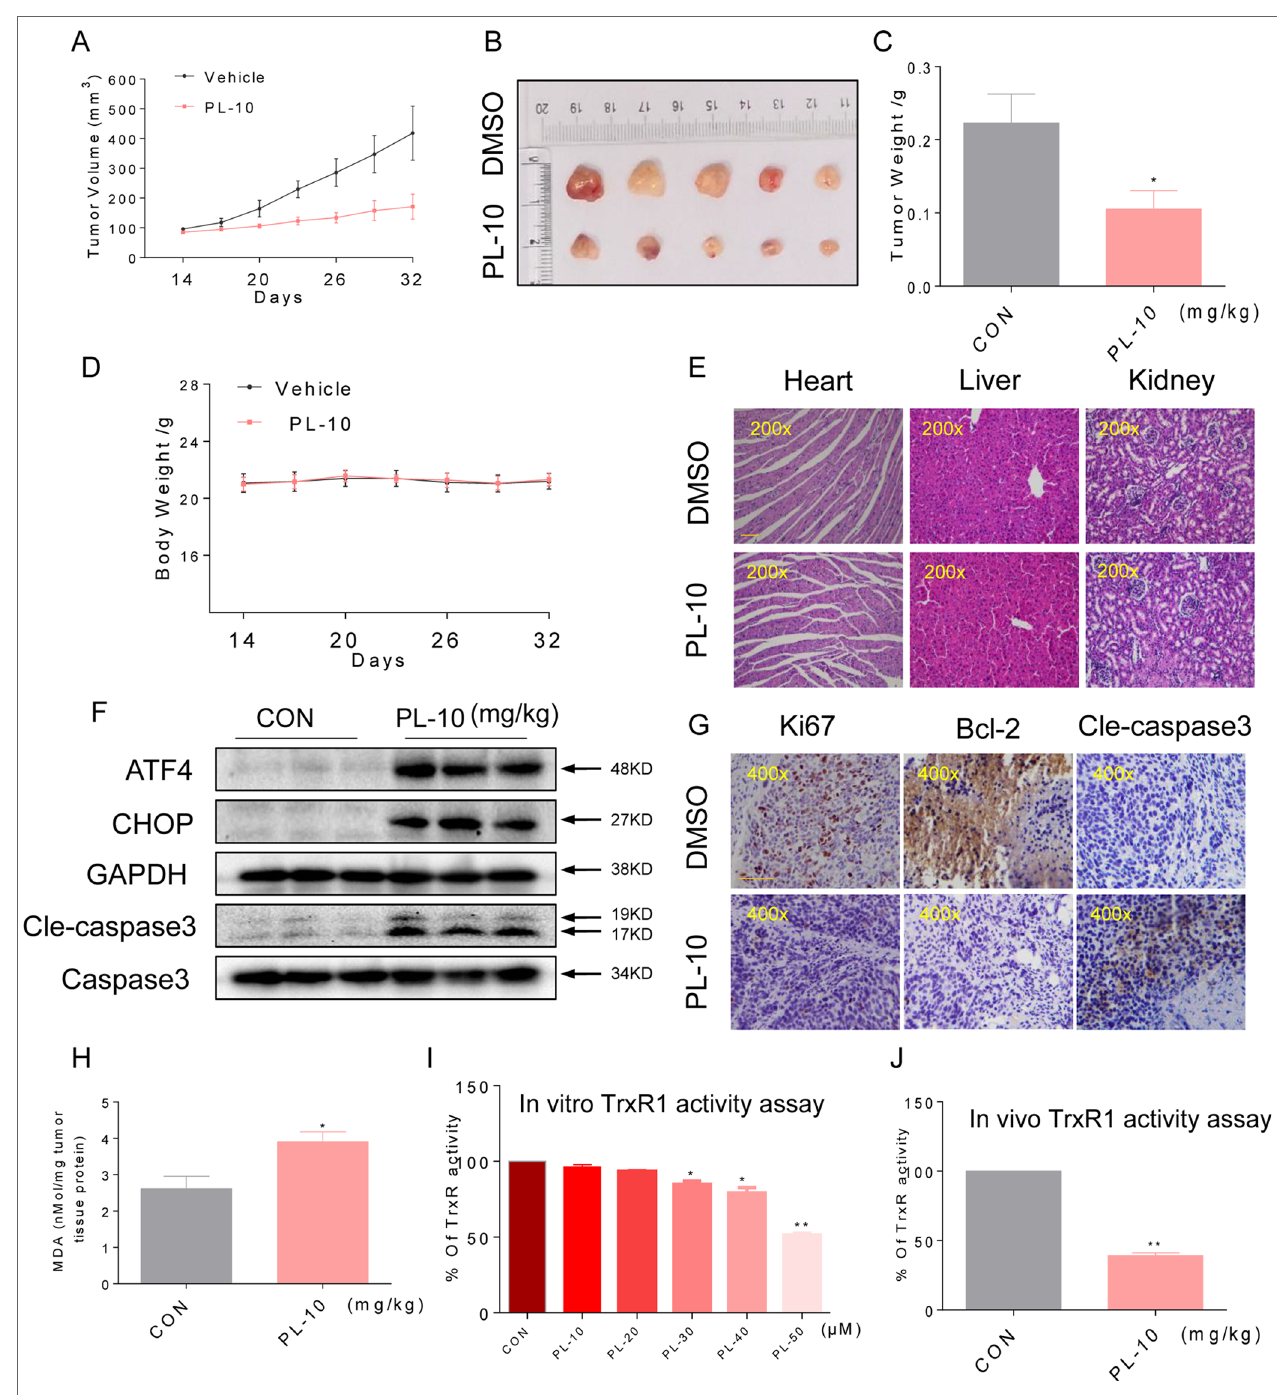
FIGURE 6 | PL inhibits HUH-7 xenograft tumor growth accompanied by increasing ROS levels and decreasing TrxR1 activity. PL treatment inhibited tumor volume (A–B) and tumor weight. (C) of HUH-7 HCC xenografts in nude mice, but did not affect the body weight. (D) of the mice. (E) H&E staining images of kidney, liver, and heart tissues from the two groups showing no significant alterations. Bar, 100 µm. (F) Western blot analysis of ATF4, CHOP, and cleaved caspase-3 levels in resected tumor specimens. Bar, 100 µm. GAPDH and caspase-3 were used as loading control. (G) Immunohistochemical staining of tumor specimens for the cell proliferation marker Ki-67, the apoptosis marker cleaved caspase-3 and Bcl-2. (H) Levels of the oxidative stress marker MDA in the tumor tissues. (I) TrxR1 enzyme activity was measured with/without PL treatment in vitro . (J) TrxR1 activity of TrxR1 in tumor tissue lysates as determined by an endpoint insulin reduction assay. Data represent similar results from three independent experiments. Error bars represent the S.E.M. of triplicate experiments (*p < 0.05, **p <